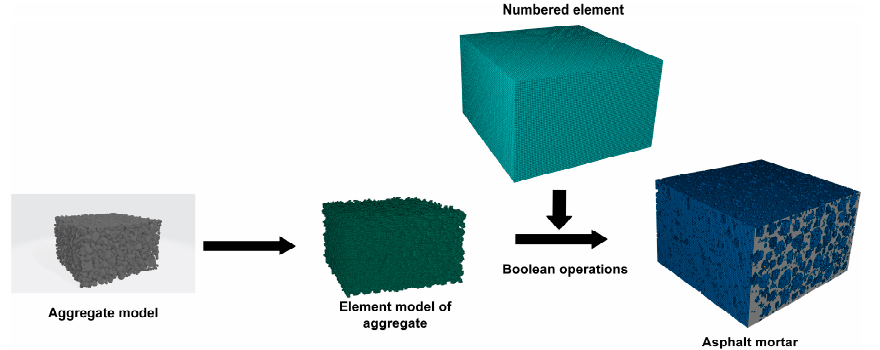
Figure 8. The generation process of the element models.